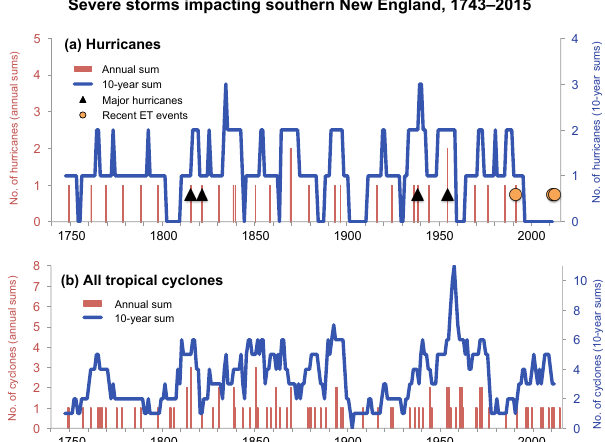
Figure 9. Annual number and decadal sums for (a) reconstructed hurricanes and (b) tropical cyclones and hurricanes in southern New England from 1743 to 2015CE. Major hurricanes (i.e., Saffir– Simpson Category 3, 4, or 5) are shown as triangles. Selected re- cent extratropical storms (the Perfect Storm of 1991, the Halloween Nor’easter of 2011, and post-Hurricane Sandy in 2012) are shown as circles. Methodology for the storm reconstructions follow those outlined in Mock